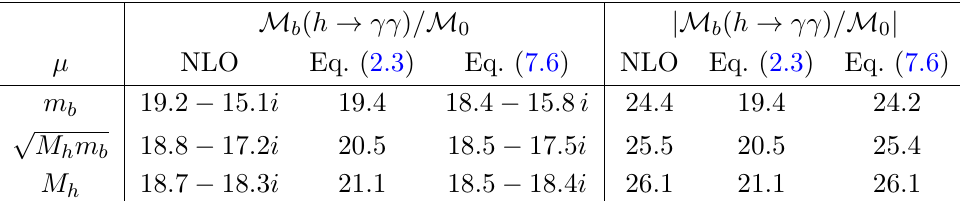
Table 1 . Numerical results for the leading double-logarithmic contributions to the decay amplitude at NLO and after resummation using the expressions given in (2.3) [40, 41, 43] and our result (7.6). The three right columns show the corresponding results for the absolute value of the decay ampli- tude. The renormalization scale of the running coupling (cid:11) s ( (cid:22) ) is varied between m b = 4 : 18 GeV and M h = 125 : 1